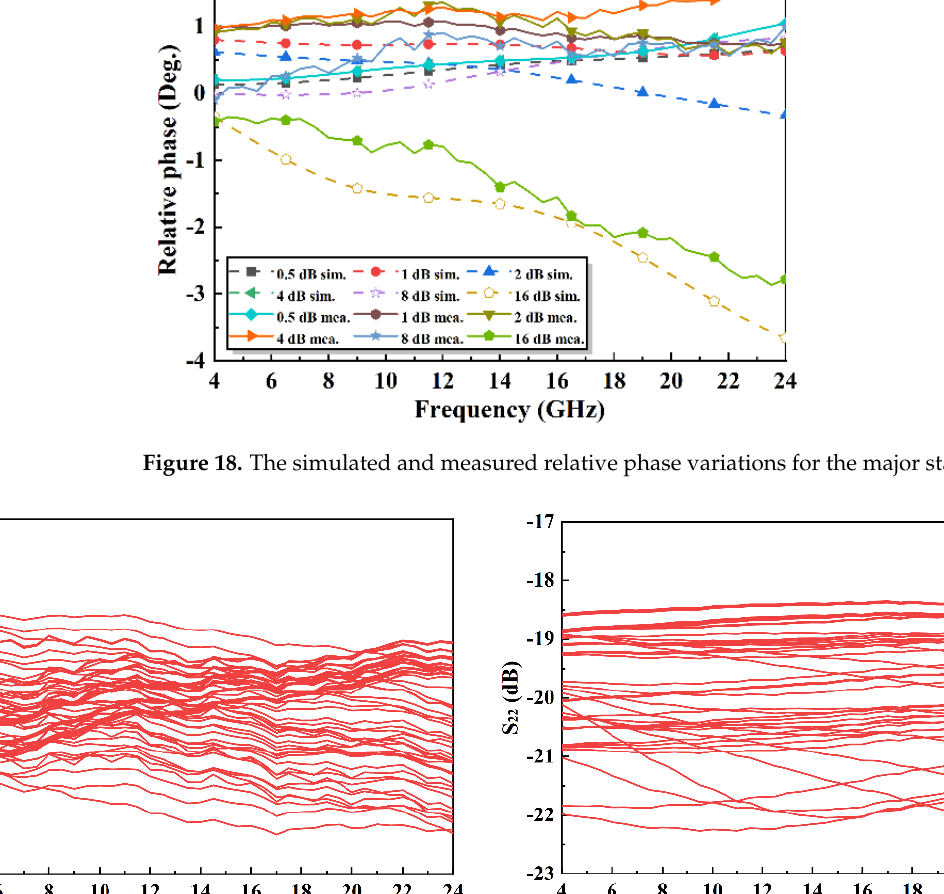
and ( b ) 𝑆 of all states. 11 22